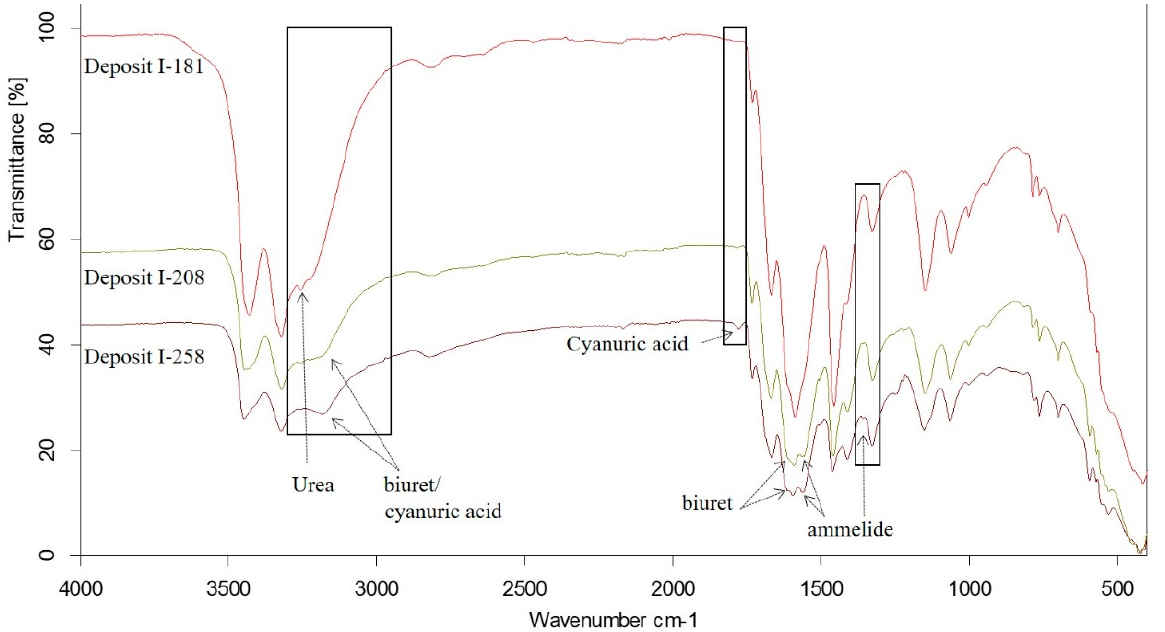
Figure 7. FTIR spectra of deposits I-181, I-208 and I-258 obtained at T air = 250 °C (T sample = 181 °C), T air = 300 °C (T sample = 208